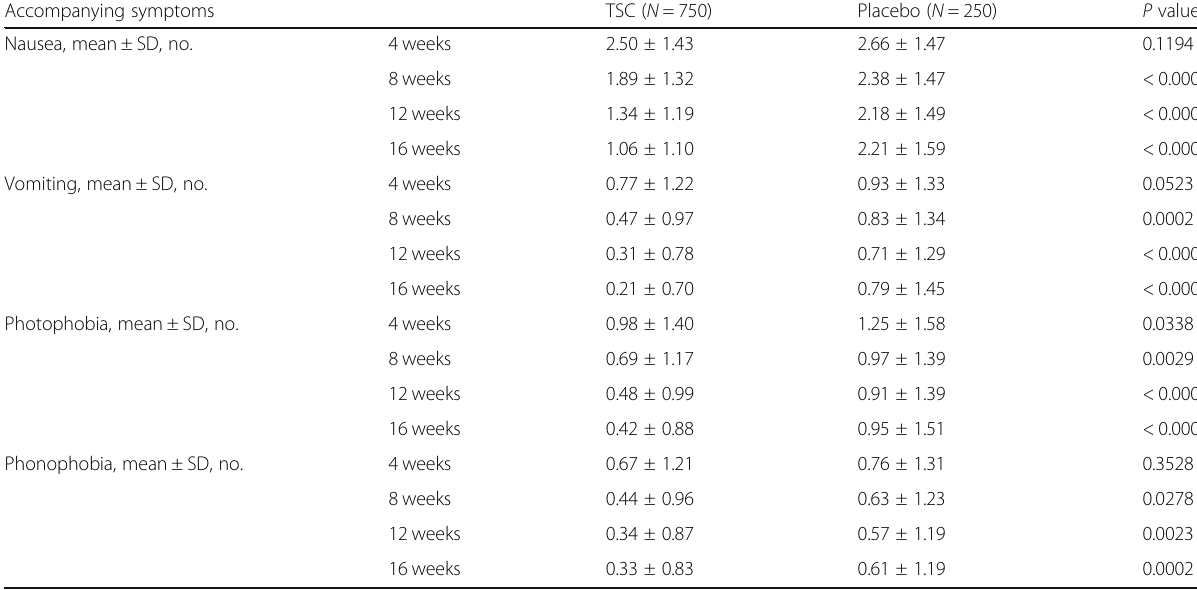
Table 5 Change in accompanying symptoms between TSC and placebo groups in the full analysis set (FAS) Accompanying symptoms TSC ( N = 750) Placebo ( N = 250) P values Nausea, mean ± SD, no.